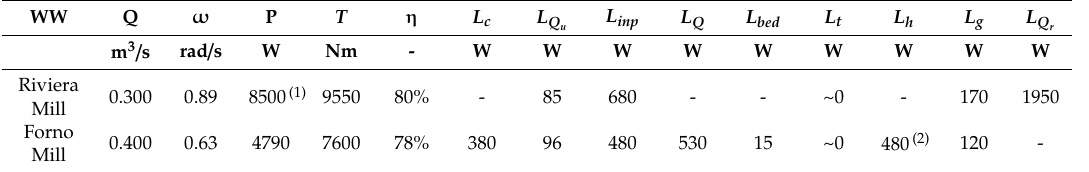
Table 2. Reference values for the two WW (see [20] and [26] for details).